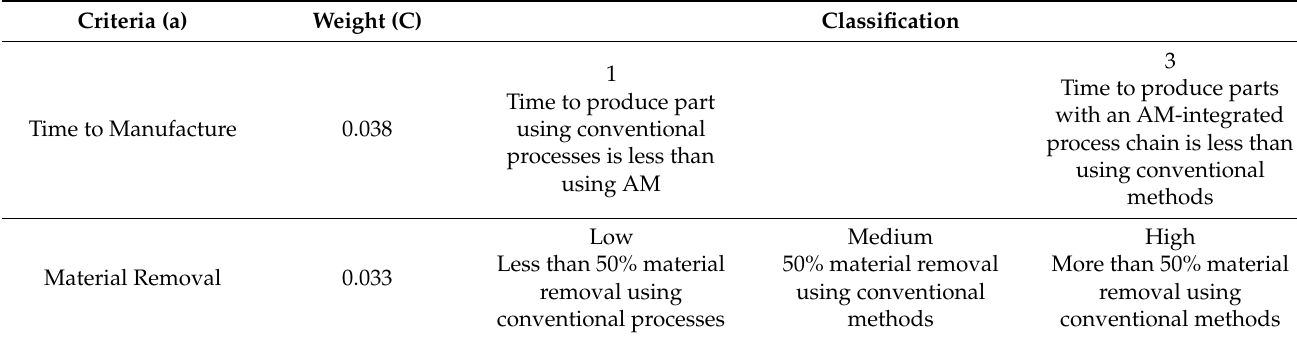
Figure 2. ( a ) Original design. ( b ) Optimised design 1. ( c ) Optimised design 3, reproduced from [60], with the permission from Inderscience, 2018. Figure 3 shows the maximum Von Mises after conducting simulation of the designs. Table 10 shows the volume, maximum Von Mises and stiffness. Optimised design 1 was considered for the application because it resulted in the highest stiffness (lowest compli- ance). A maximum stress constraint was not considered in the design, although all the maximum Von Mises values were below the yield strength of the material used, which is a selective laser-melted Ti-6Al-4V.